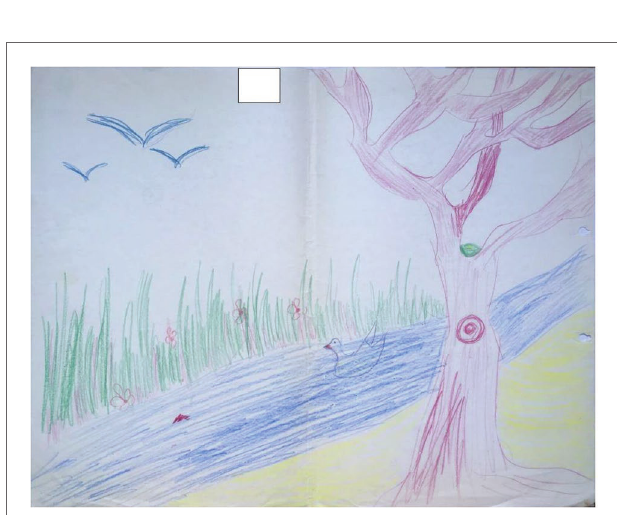
FIGURE 3 | Example of a drawing exhibiting a low degree of closeness based on the analysis of the drawing’s content and pictorial elements.